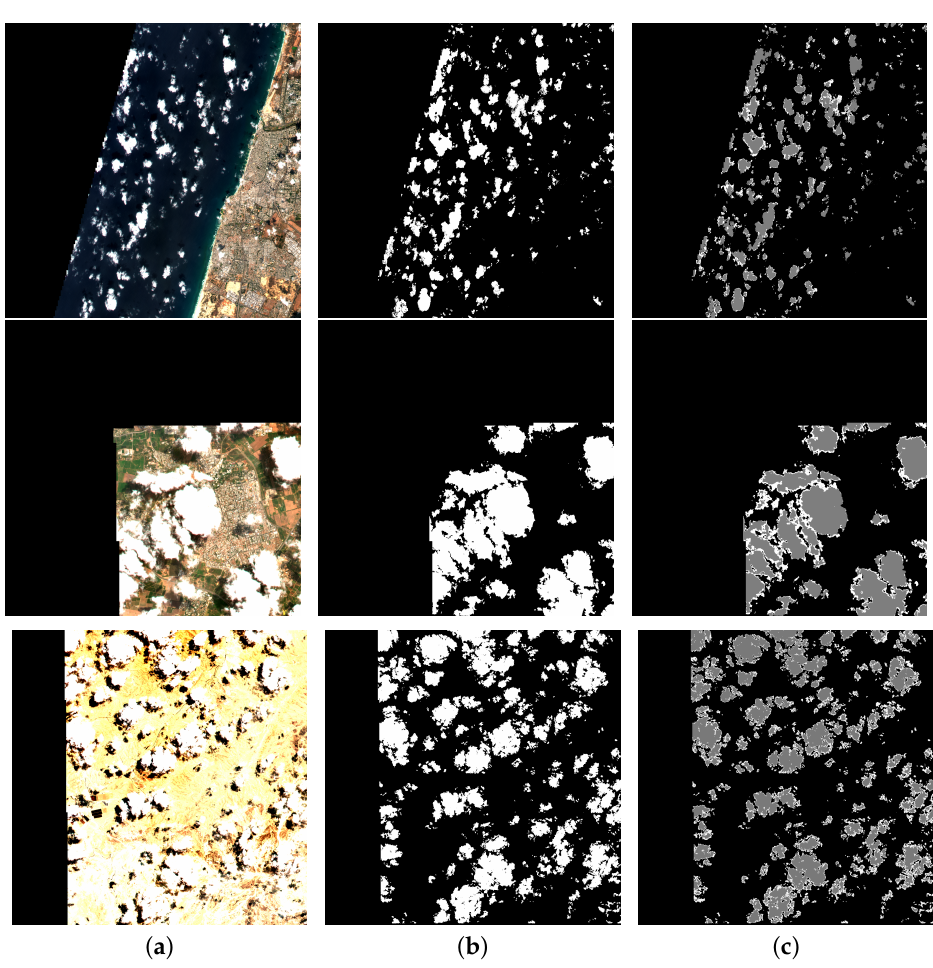
Figure 4. Comparison of manual binary and multi-class cloud masks: ( a ) RGB representations of patches of VEN µ S tiles; ( b ) binary mask; ( c ) multi-class mask, thick clouds (in grey) and thin clouds (in